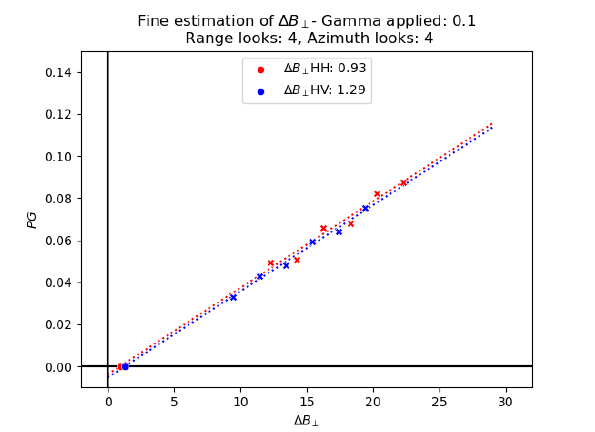
Figure 12. Fine estimation of ∆ B ⊥ from HH and HV data in pair #2